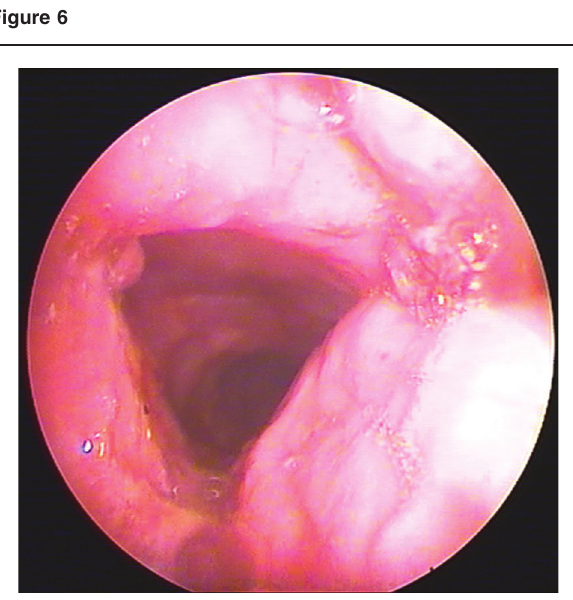
Table 5 Different criteria of stenosis in successful and unsuccessful cases and their percentage in each of them